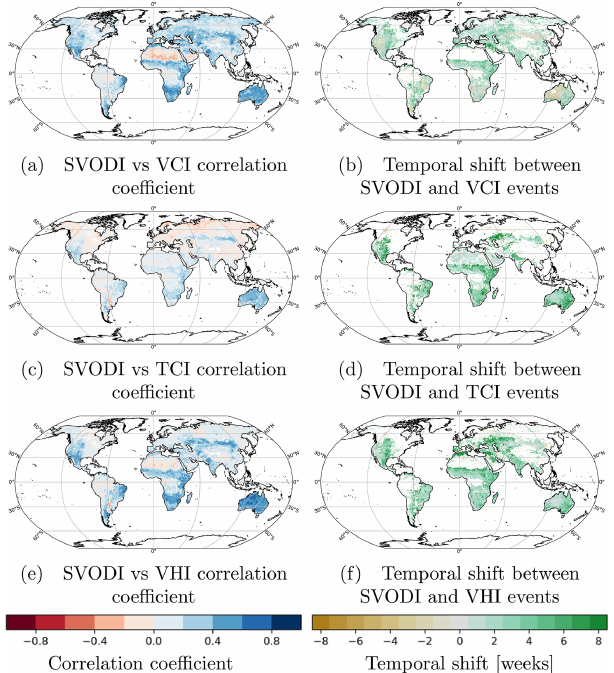
Figure 7. Correlation coefficient without temporal shift between SVODI and VCI (a) , TCI (c) and VHI (e) and the temporal shift at which a maximum correlation is obtained (b, d, f) . All results are based on weekly means; positive (green) values in the shift plots in- dicate that anomalies are visible in VCI, TCI or VHI before SVODI. Figure 8. Correlation (a, c, e, g) and temporal shift (b, d, f, h) be- tween SVODI and soil moisture anomalies from ERA5, based on weekly data. Positive (green) values in the shift plots indicate that anomalies are earlier visible in soil moisture than in